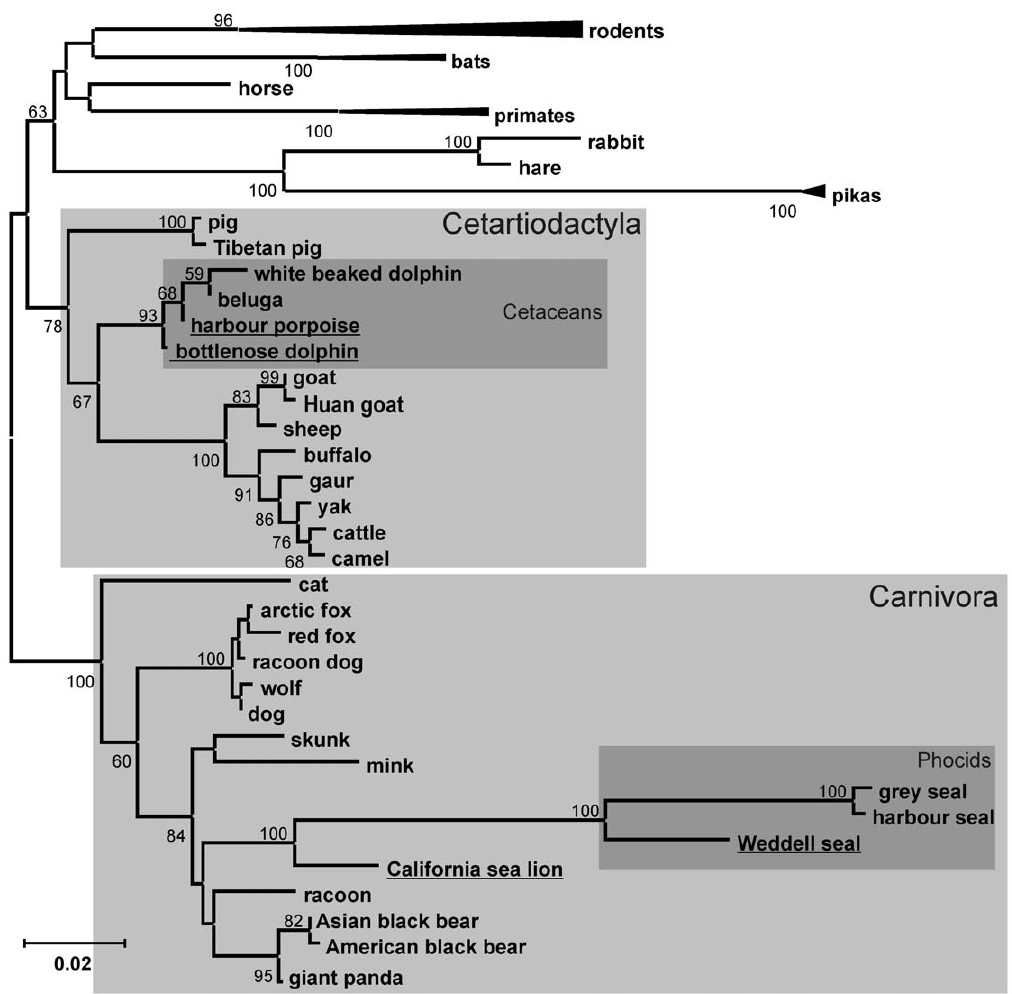
Figure 2. Pinniped and cetacean leptin sequences clade within the Carnivora and Cetartiodactyla respectively. Neighbour-joining (NJ) analysis, using the Tamura 3-parameter method with 1000 replicates, comparing diverse nucleotide sequences of mammalian leptin sequences with the sequences isolated in this study (underlined). The tree was rooted at the midpoint and support for each node (expressed as a percentage) is shown when . 50%. The rodent, primate and lagomorphs clades have been collapsed for clarity. Evidence of positive selection was detected along the branch leading to the phocids indicated with ‘*’. Consistent topologies were predicted using Neighbour-joining and Maximum Likelihood methods (data not shown – see Methods for